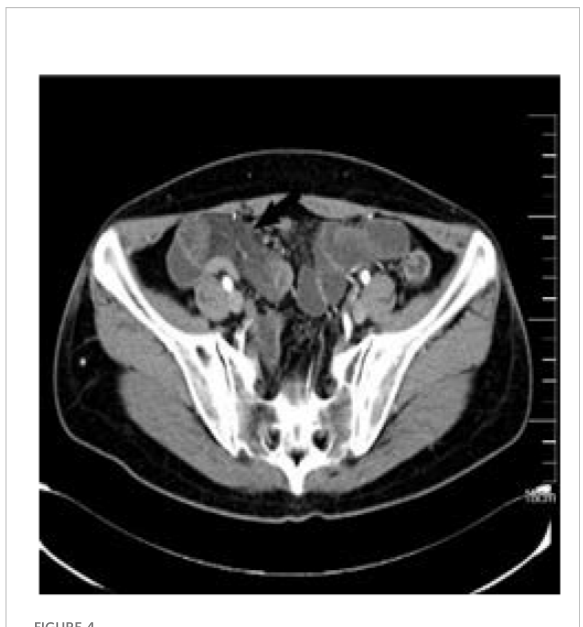
FIGURE 4 CT of patient B ’ s abdomen. Pelvic local intestinal wall edema, disorder, and mesenteric edema.